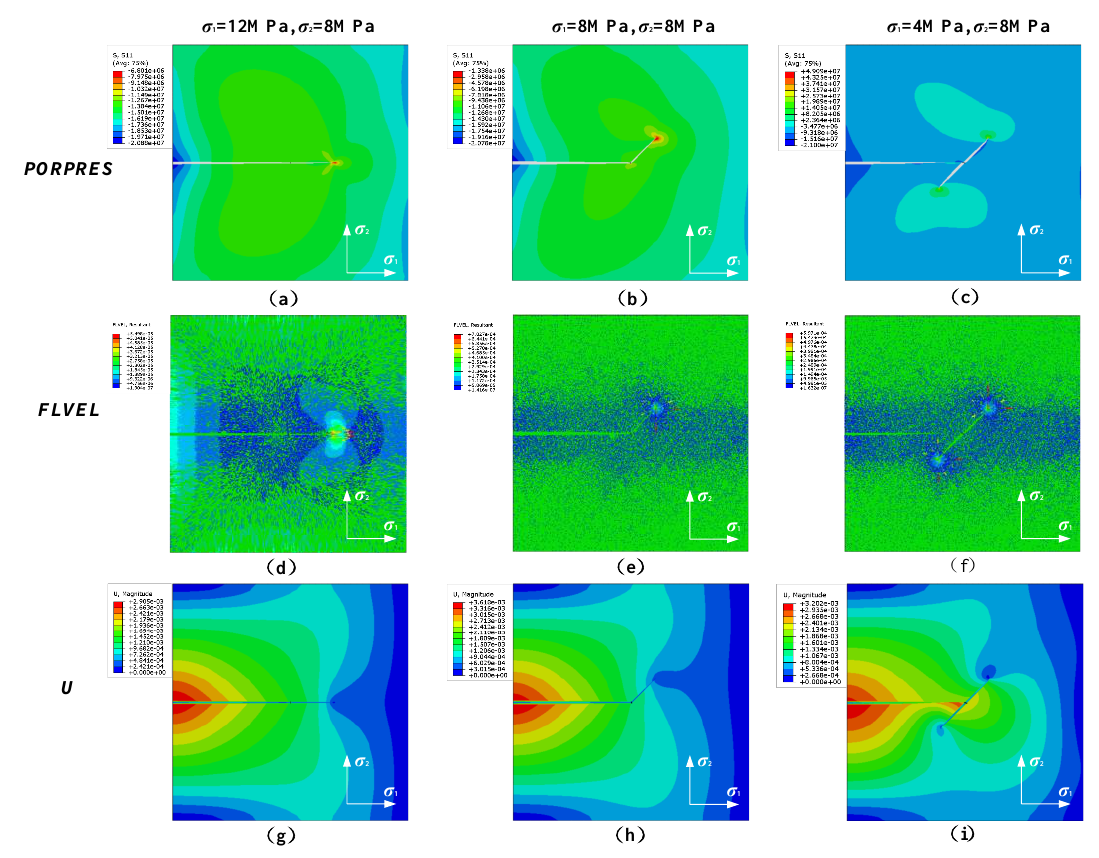
Figure 17. Expansion of artificial prefabricated cracks in different stress fields. ( a ) PORPRES, σ 1 = 8